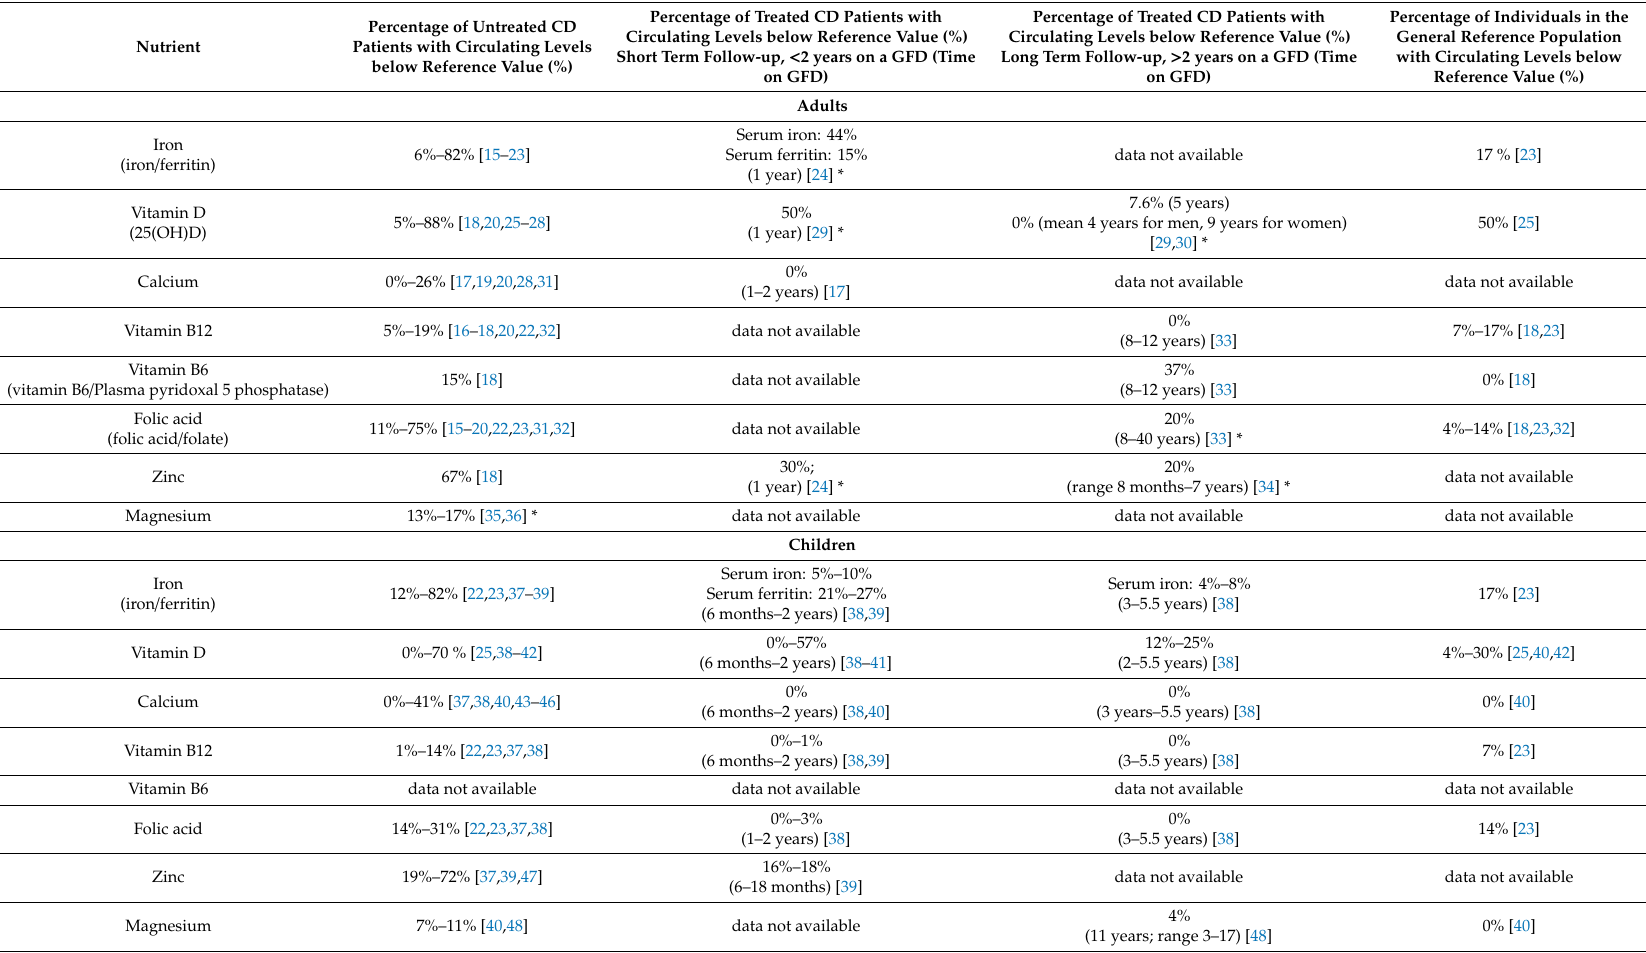
Table 1. Overview of nutrient deficiencies at diagnosis and during follow-up on a gluten-free